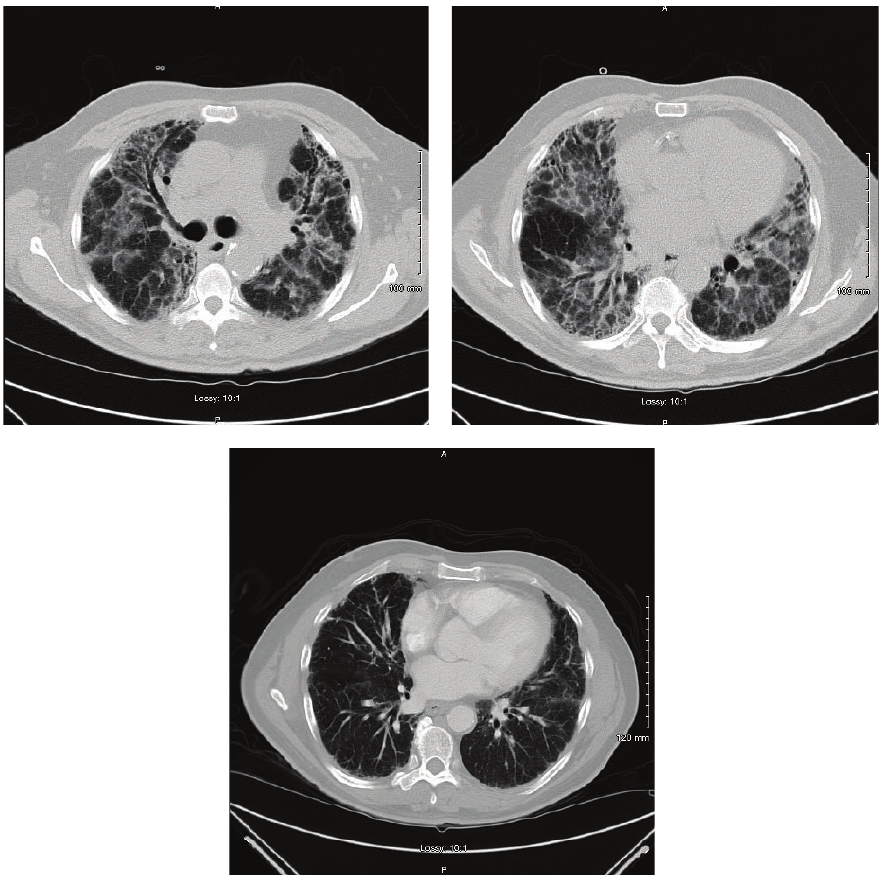
Figure 3: CT scan of the chest showing extensive honeycombing consistent with